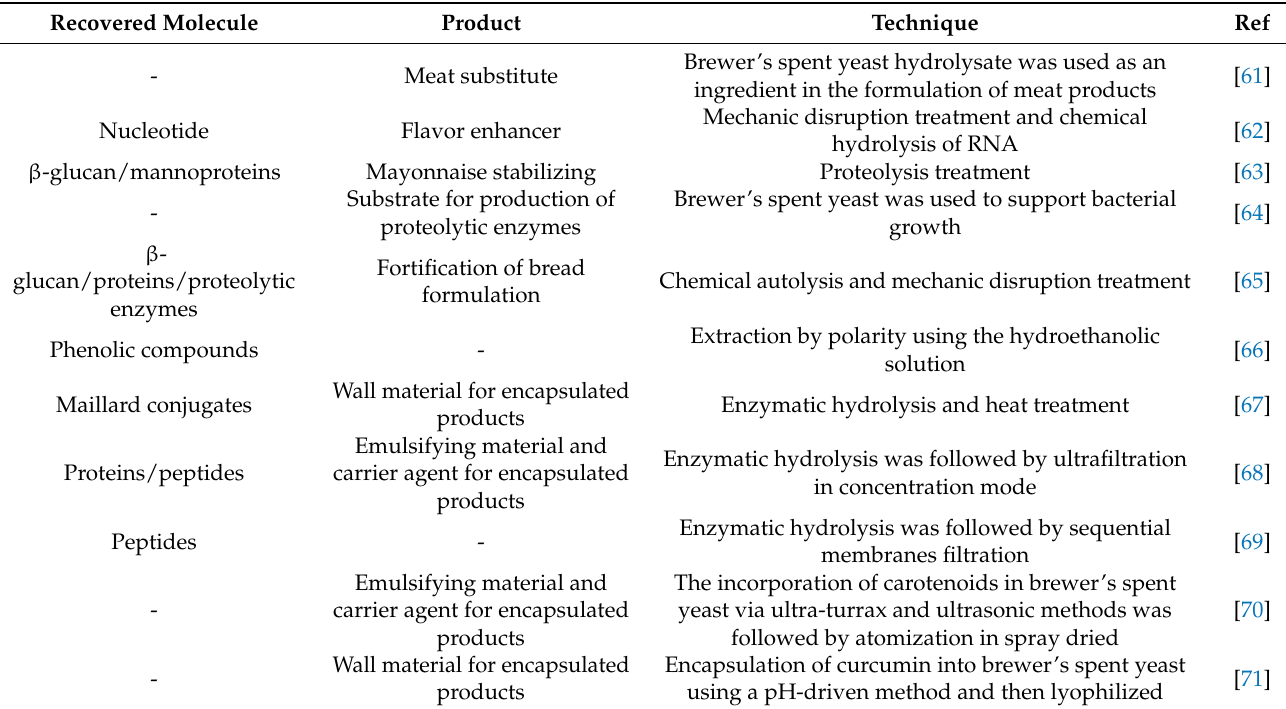
Table 3. Studies about compounds used from brewer’s spent yeast attractive to the food